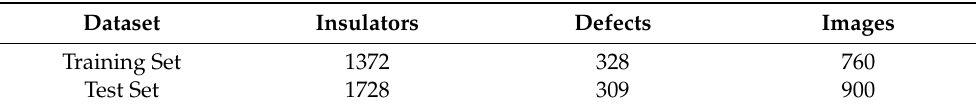
Table 4. Dataset sample distribution.